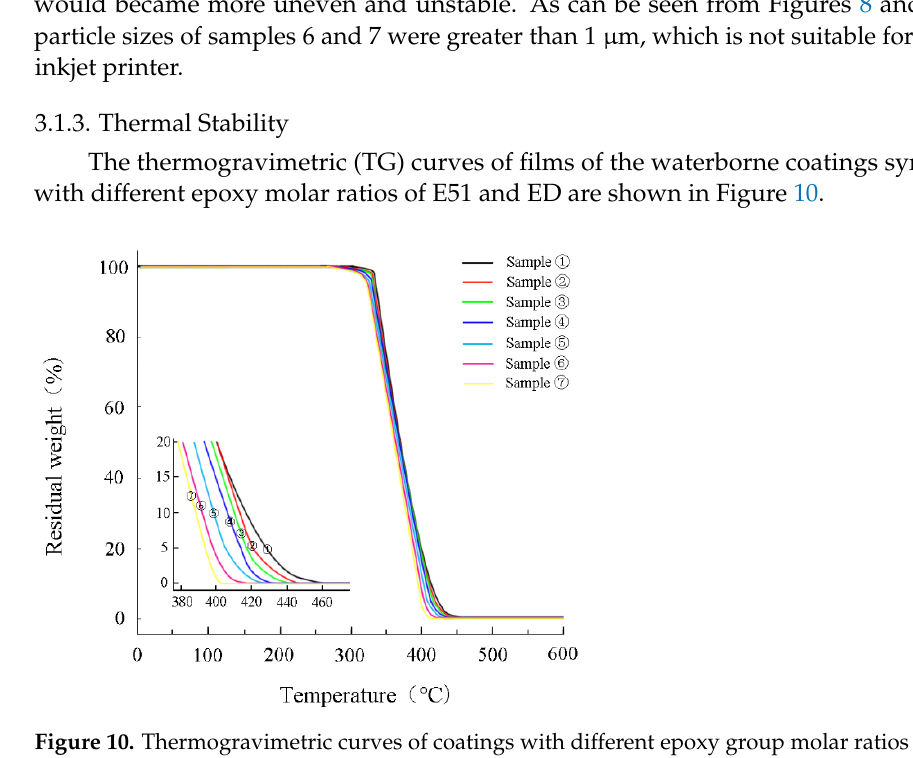
Figure 9. The particle size distribution of the system when the molar ratio of epoxy groups is E51:ED = 1:3.